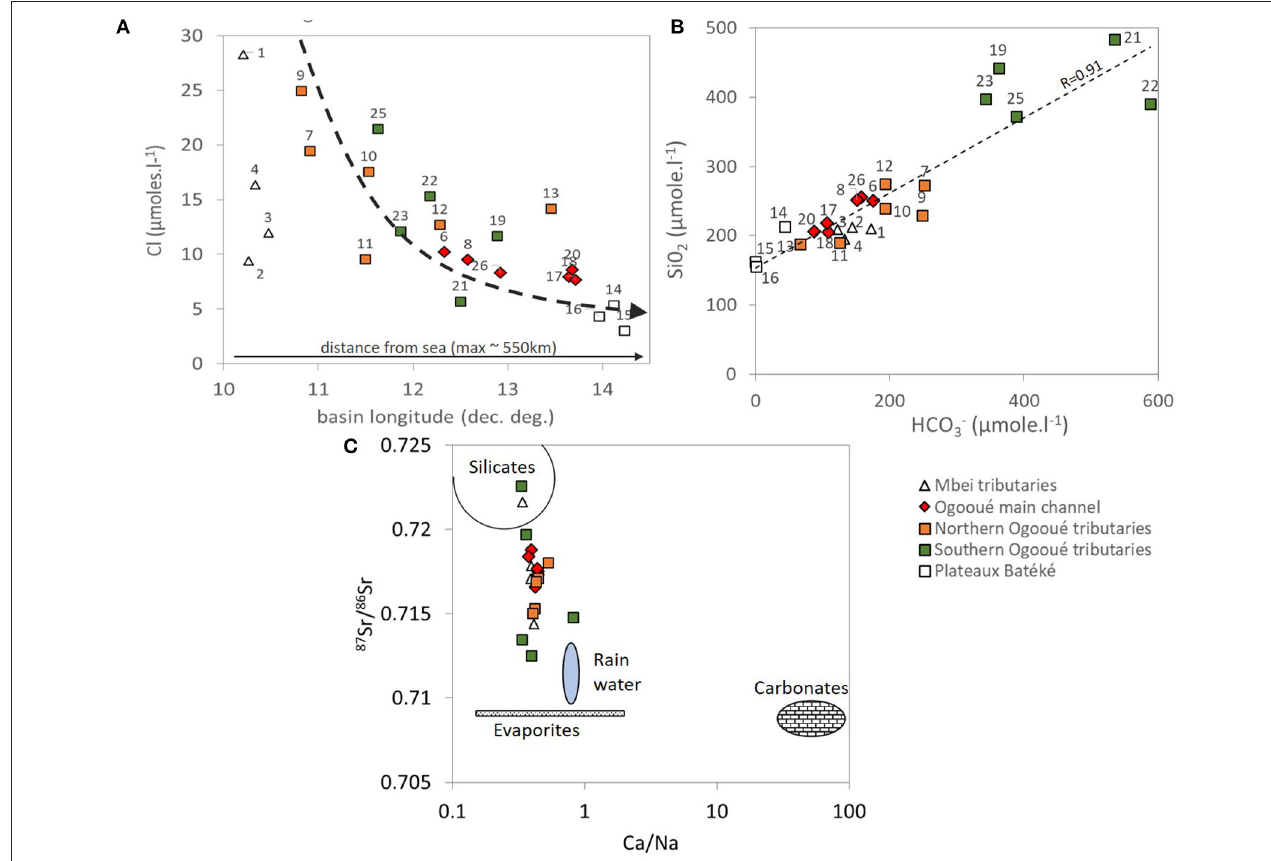
FIGURE 4 | Main characteristics of the dissolved load of the tributaries of the Ogooué and Mbei basins (A) Cl − concentration as function of the centroid basin location. The dotted line represents the decreasing Cl − concentration from the coast (B) SiO 2 vs. HCO − 3 . (C) 87 Sr/ 86 Sr ratio vs. Ca/Na (rock weathering end members defined by Négrel et al.,